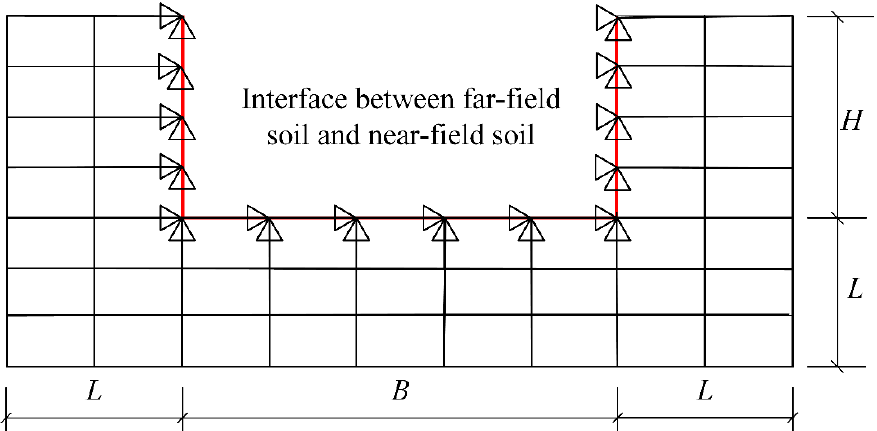
Figure 2. Schematic of artificial damping finite region with the additional constraint boundary.